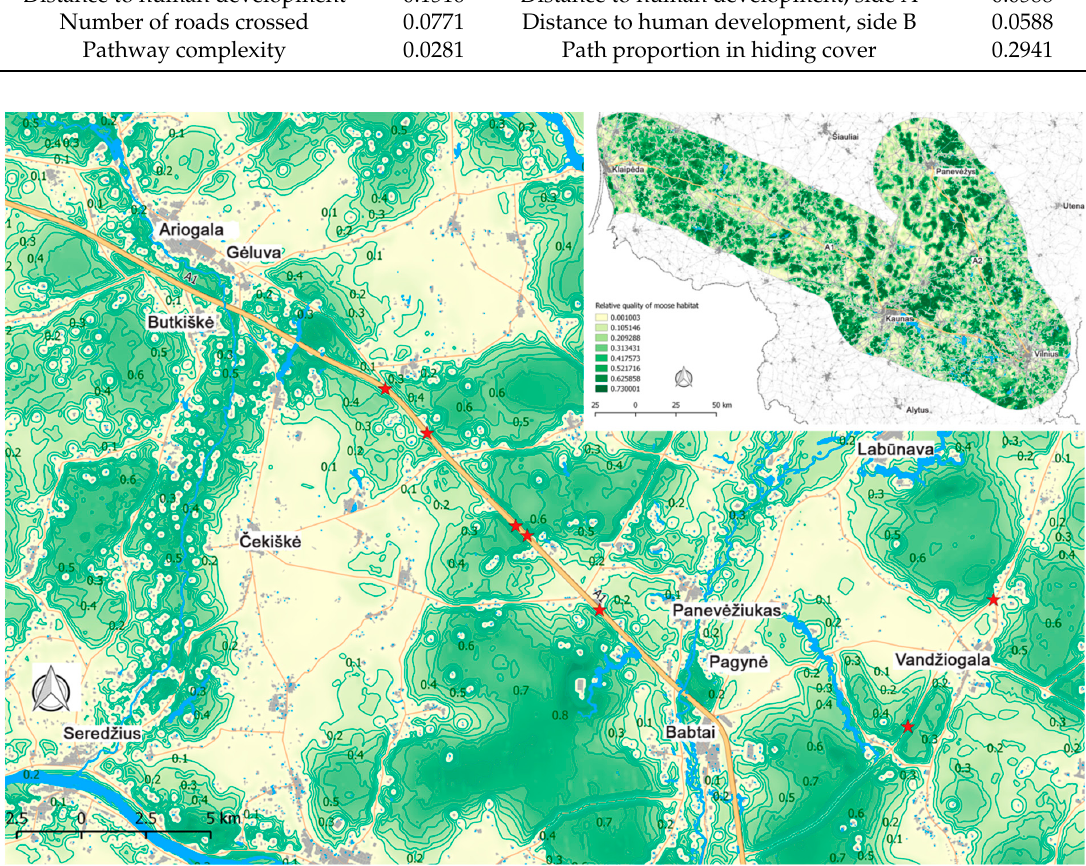
Figure 4. Close-up of the realized moose habitat map with HSI contour lines. Stars mark the locations of moose-vehicle collisions from 2002–2013. The realized habitat map for moose within the 30 km buffer each side of highway A1 and A2 is shown as an inset. The map was created in QGIS version 2.8 “Wien” (http://www.qgis.org/), licensed under the GNU General Public License, using background data from the Lithuanian Asset Information System (http://lakis.lakd.lt/lakis/).